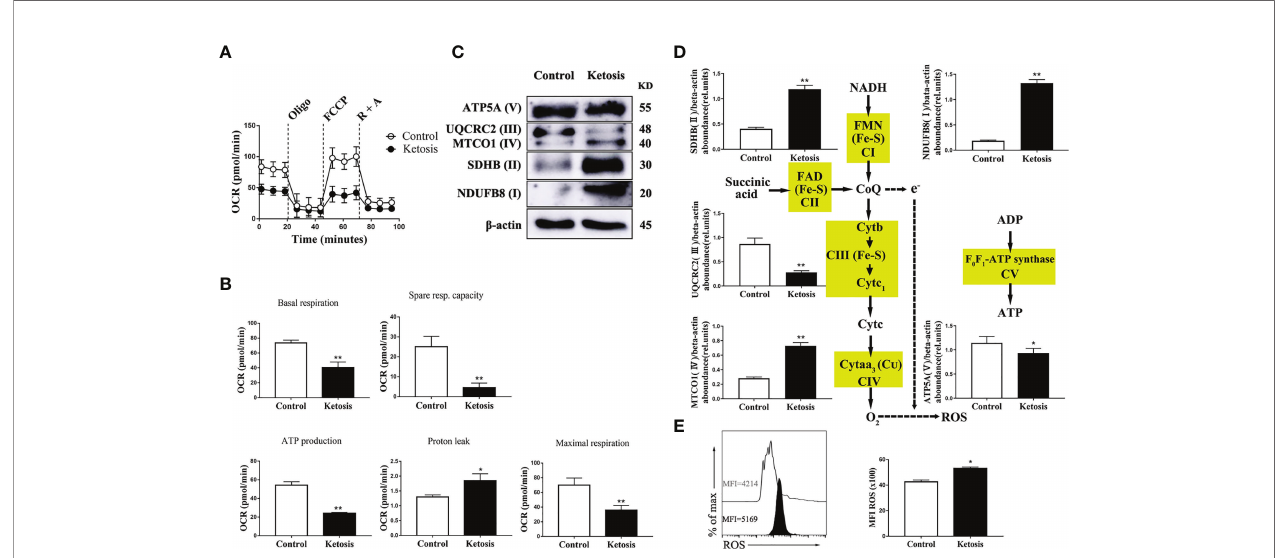
FIGURE 3 | Decreased level of oxidative phosphorylation metabolism following ketosis underlie increased production of ROS in CD4 + T cells. (A – E) CD4 + T cells were sorted from healthy and ketotic cows. (A) Oxygen consumption rates (OCRs) measured by extracellular fl ux analysis (n = 4 per group). T cells were measured under basal conditions. Oligo, oligomycin; R, rotenone; A, antimycin. (B) Mean (± SEM) of basal and maximal respiration (after FCCP), ATP production, proton leak and spare respiratory capacity from vivo-isolated CD4 + T (n = 4 per group). (C) Western blot analysis of ETC complex proteins in CD4 + T cells from healthy and ketotic cows (n = 6 per group). (D) Relative abundance of ETC complex proteins (n = 6 per group). (E) The level of ROS was analyzed by fl ow cytometry (n = 6 per group). For all bar plots shown, data are expressed as the means ± SEM, *P < 0.05, **P < 0.01 by independent-samples